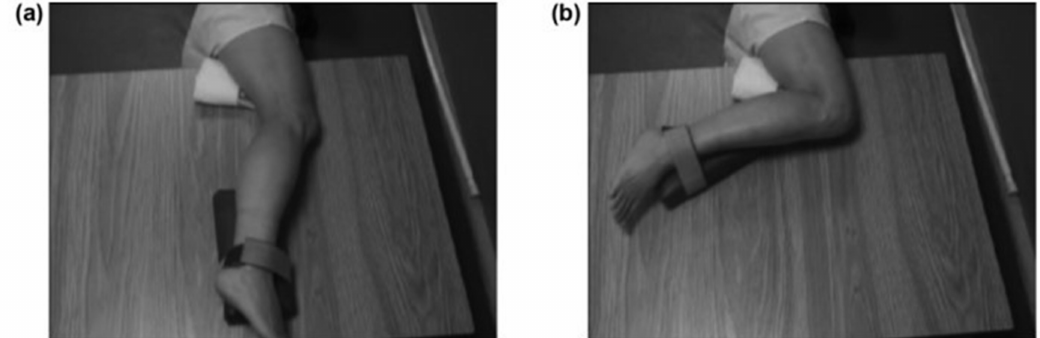
Figure 3. Out of Synergy Position for Knee Flexion Practice. Panel ( a ) is the start position for the out-of-synergy position for knee flexion practice. The out-of-synergy exercise is more difficult in that the hip is no longer in a flexed position as in Figure 2. Rather, the hip is in an extended position or neutral position, as shown here, at the start of the exercise, and the participant is directed to maintain this hip position throughout. Panel ( b ) shows the end position of the motor task, which is to flex the knee and maintain the hip in extended or neutral position (with permission, JRRD, 2012, Daly et al.